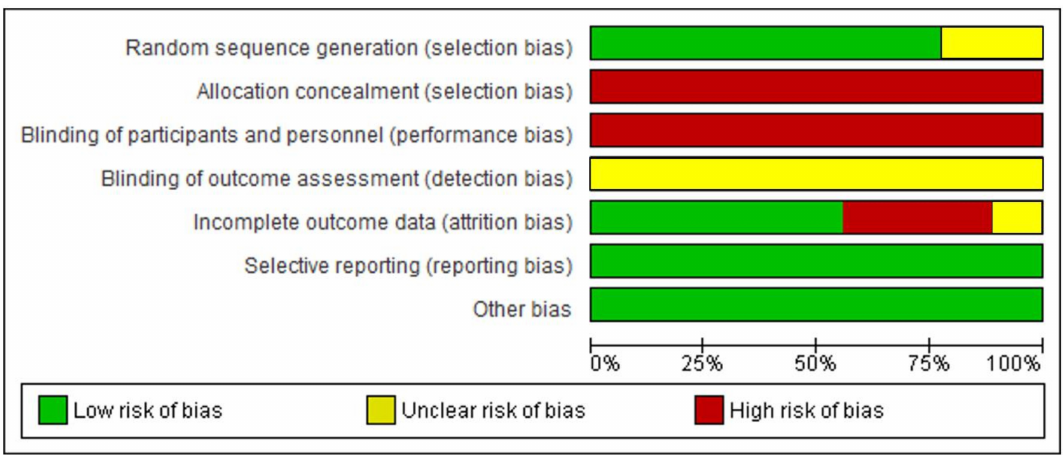
Figure 1. Flow chart of study selection. SD: Standard deviation.